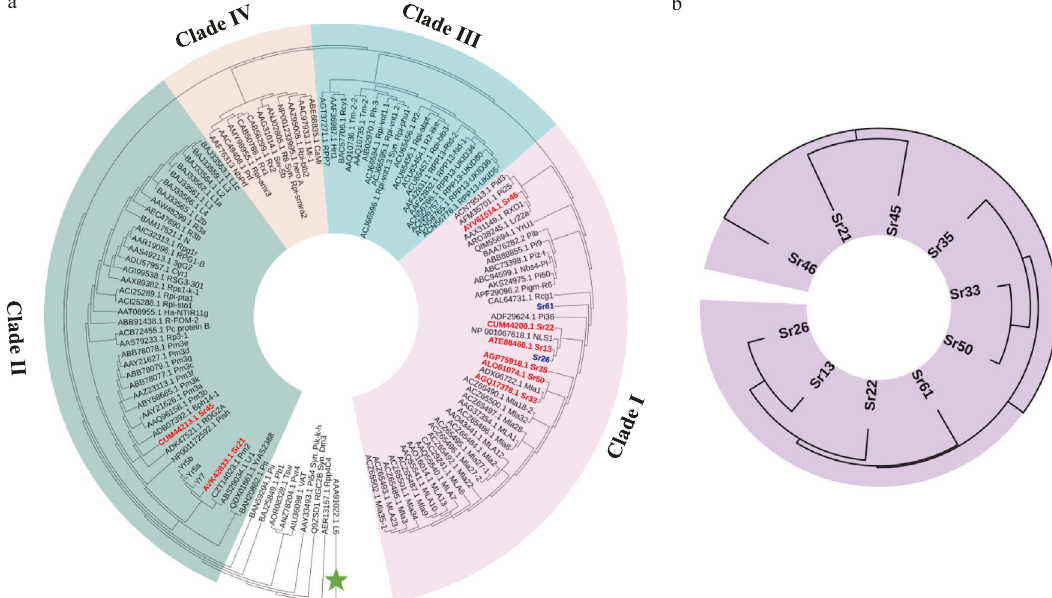
Fig. 3 Phylogenetic relationship between Sr26 , Sr61 and other CC-NLR immune receptors from plants. a Comparison of 123 NLR type proteins formed three large clades (I – III) and one smaller clade (IV). The TIR type NLR protein encoded by the Linum usitatissimum L6 rust resistance gene was used as an outgroup (green star). Previously cloned wheat stem rust genes are in red script; Sr26 and Sr61 are in blue; and Clades I, II, III, IV are shaded in purple, green, blue, and light orange, respectively. b Simpli fi ed phylogenetic tree showing the evolutionary relationship between all ten cloned wheat stem rust R genes that encode CC-NLR